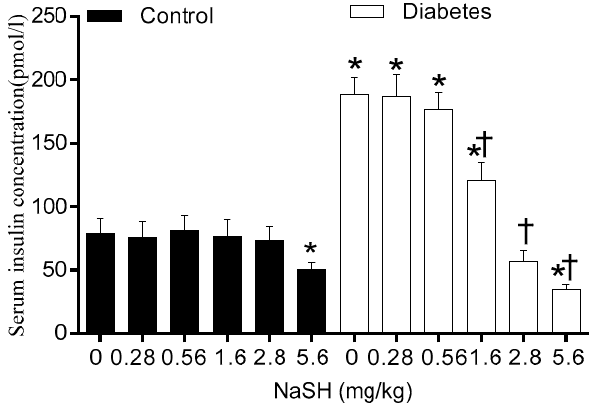
Figure 4. Effect of NaSH administration on fasting serum insulin levels at the end of the study. Results are mean ± SEM (n = 8/group). * p < 0.05 compared to non-treated control rats, † p < 0.05 compared to non-treated diabetic rats.